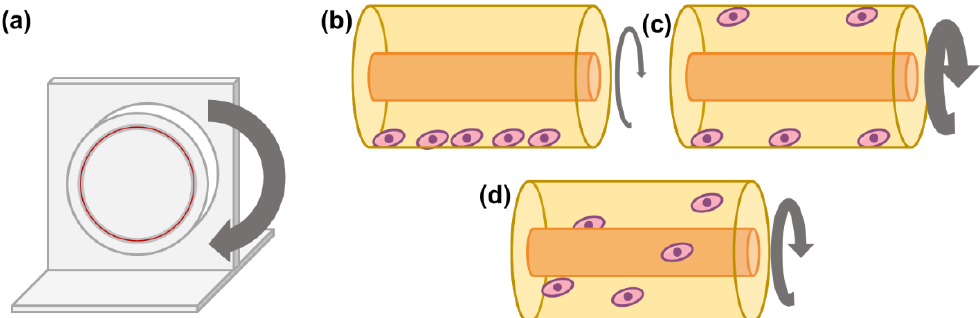
Figure 5. Schematics of a rotary cell culture system (RCCS): ( a ) four-station rotator base with one 50 mL vessel and two 10 mL vessels; ( b ) at low rotation speeds, the cells will settle along the bottom of the vessel; ( c ) at very high rotational speeds, the cells will be subjected to a predominant centrifugal force, driving them towards the outer wall of the vessel; and ( d ) at a certain velocity range, the cells will be in suspension, in a simulated microgravity environment.